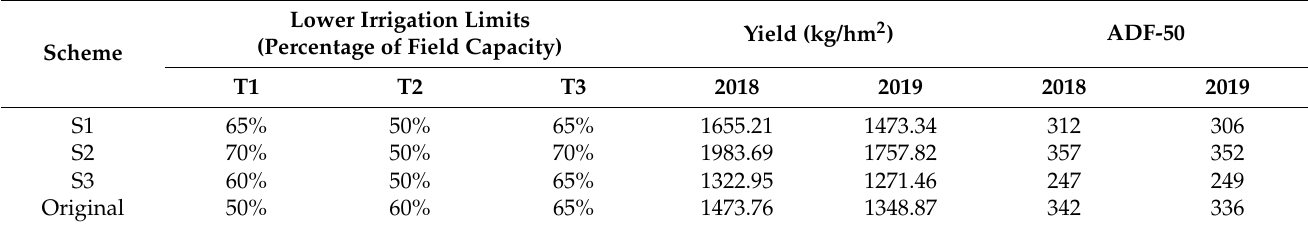
Table 1. Functions’ values for the 3 treatments.